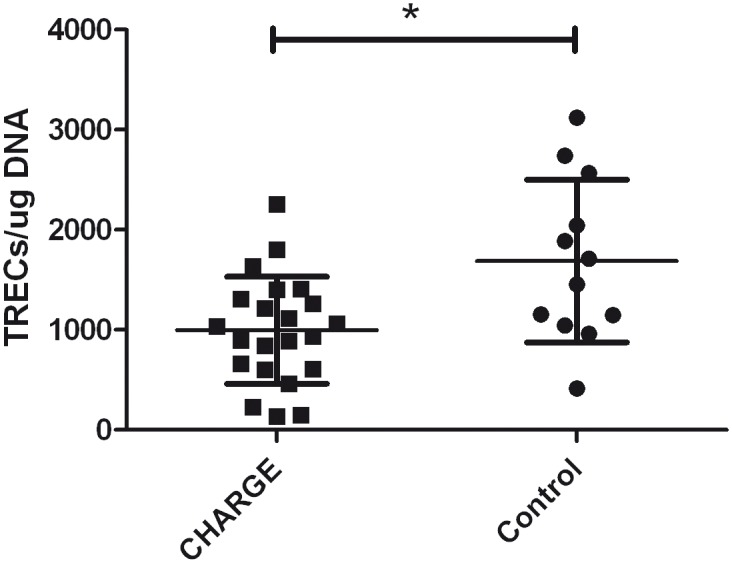
T-cell receptor excision circle (TREC) analysis.Numbers of TRECs in patients with CHARGE syndrome (n = 22) compared to healthy controls (n = 12). Error bars indicate means and standard deviations, *p = 0.005.